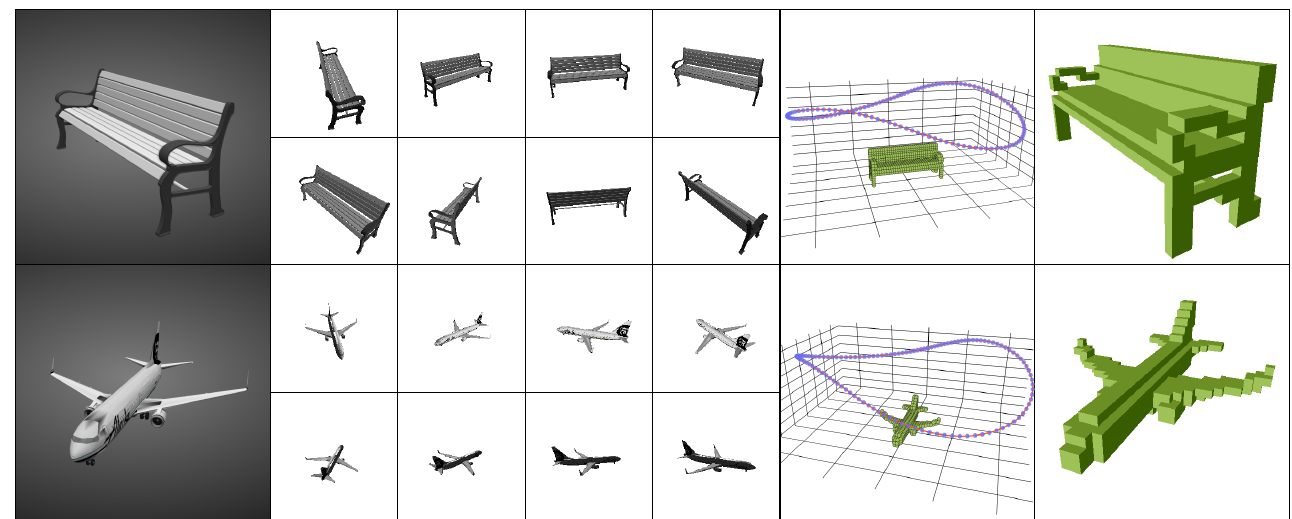
Figure 5. Two examples of our new rendering of the ShapeNet dataset. From the left, we first show the models as displayed on the taxonomy viewer on the ShapeNet website; next, we show eight of its input renderings. Lastly, we show the path along which the images were taken and the ground-truth